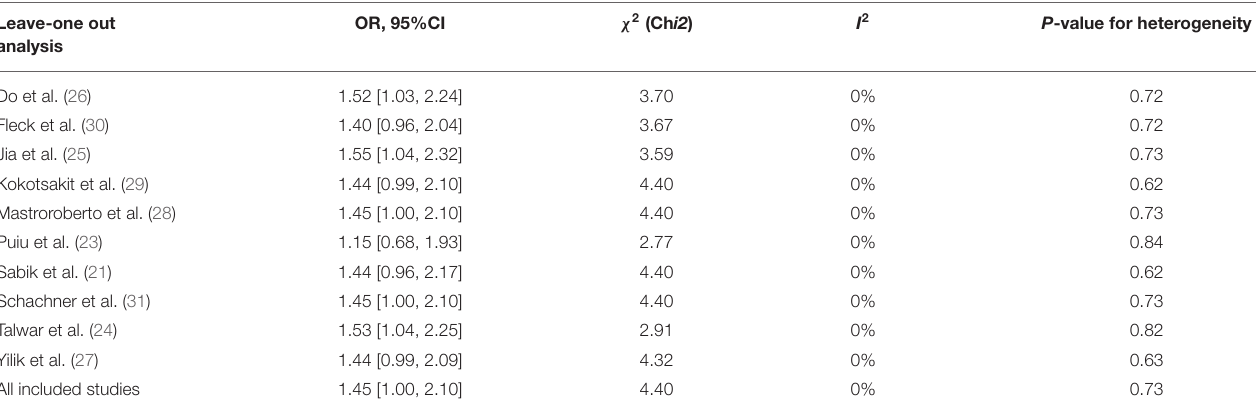
TABLE 4 | Sensitivity with leave-one out analysis for neurological analysis.